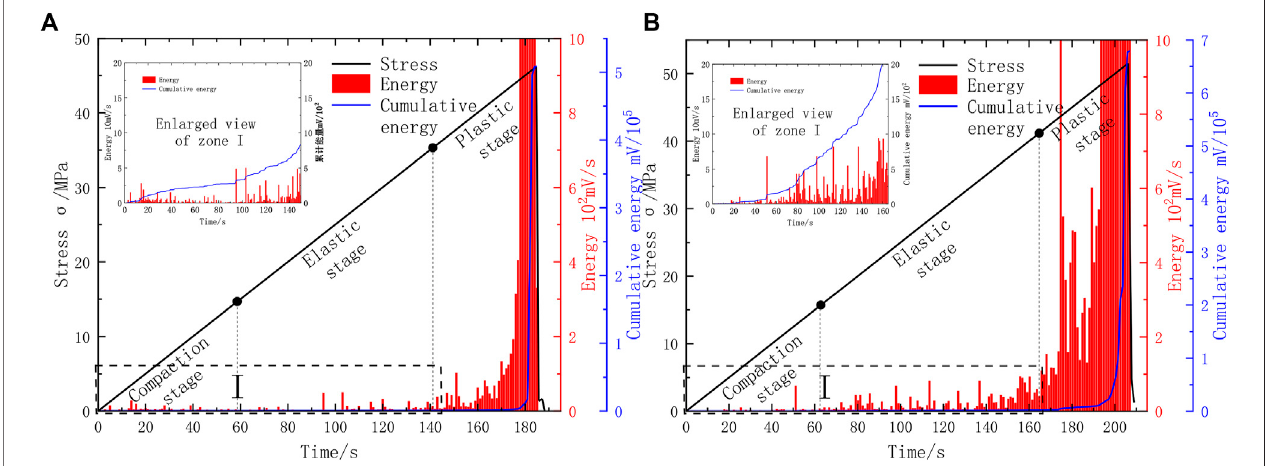
FIGURE8 | Relationship betweenacoustic emission energy and cumulative energy ofrock sample and stress: (A) Unanchored bedding sandstone; (B) Anchored bedding sandstone.